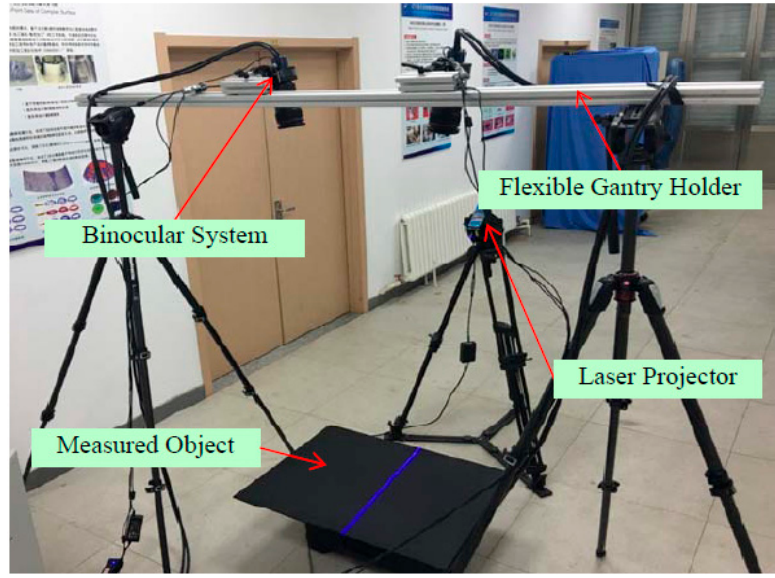
Figure 8. The experimental system used for high-precision measurement.